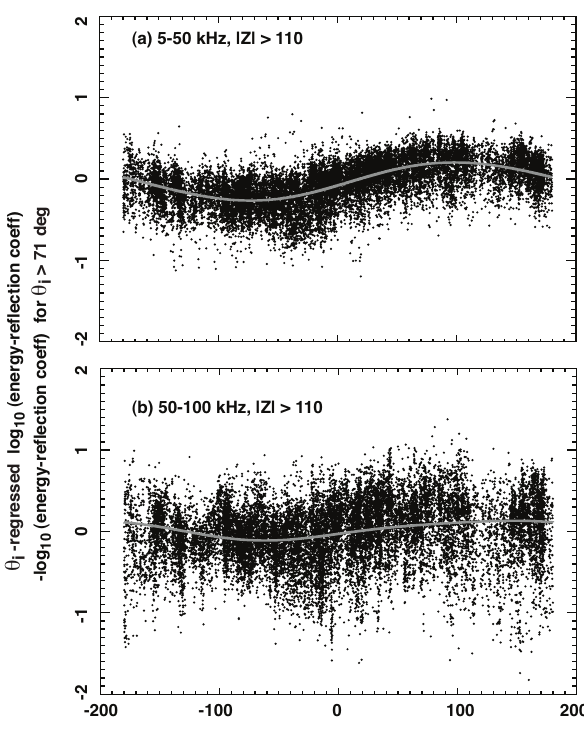
Fig. 7. Propagation-azimuth dependence of zenith- and range- regressed data for pure-nighttime values of solar zenith angle. Si- nusoidal (fundamental + second harmonic) fit is shown as smooth